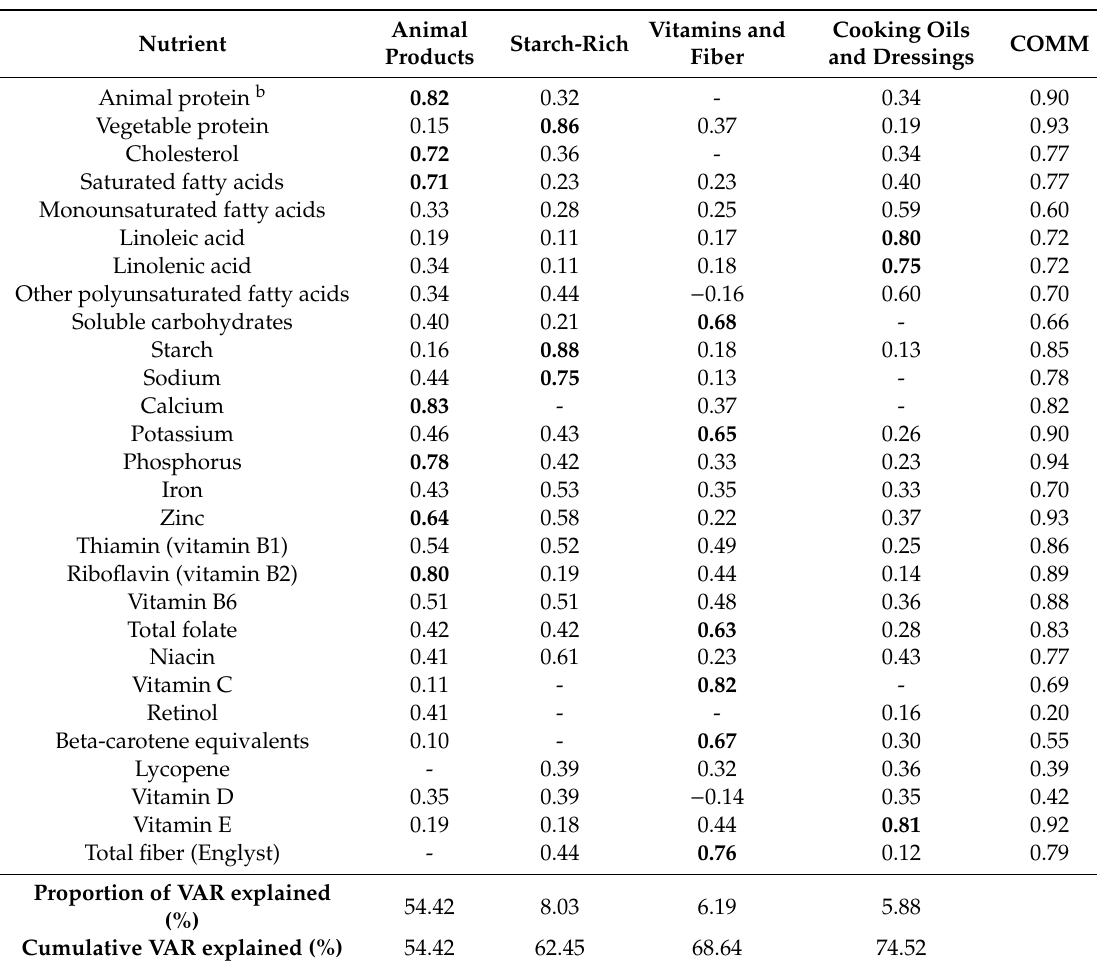
Table 2. Factor loading matrix a , communalities (COMM) and explained variances (VAR) for the four major dietary patterns identified by factor analysis.